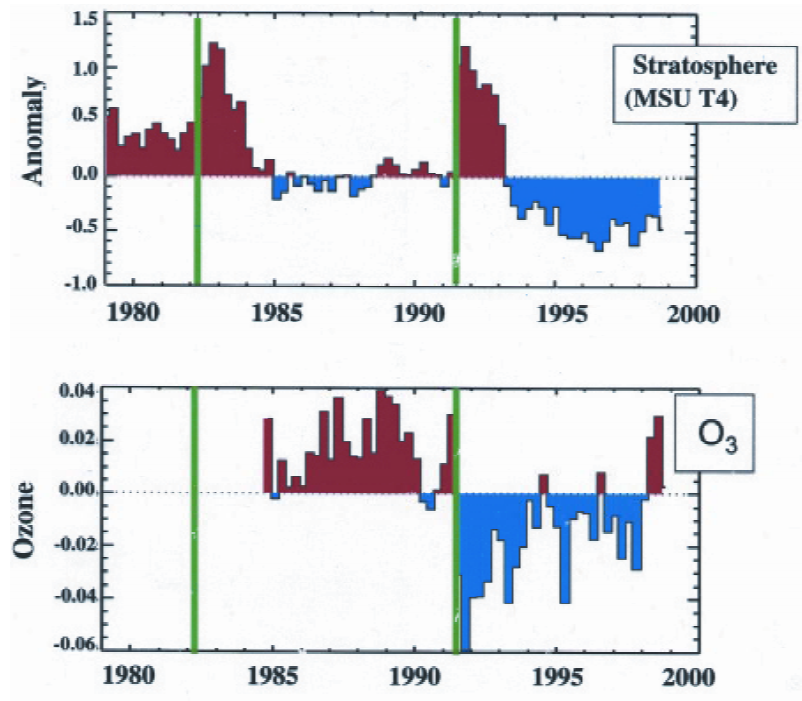
FIGURE 6. Comparison of lower stratospheric temperatures and ozone concentrations. (a) Temperatures; (b) ozone levels. Note stepwise drop in both records after 1991 Pinatubo